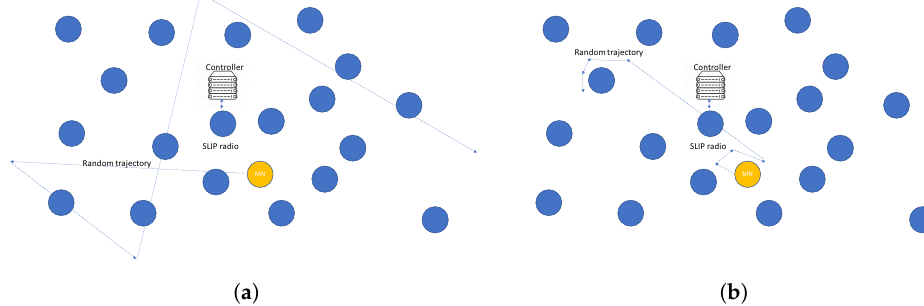
Figure 16. Simulation scenarios with different mobility patterns: ( a ) with RDM mobility pattern and ( b ) with TLW mobility pattern.